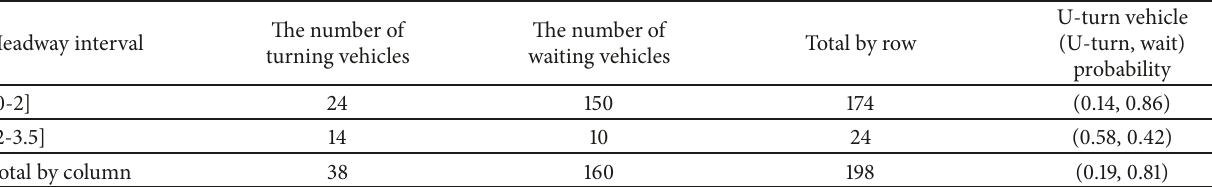
Table 3: Headway statistics in different scenes.